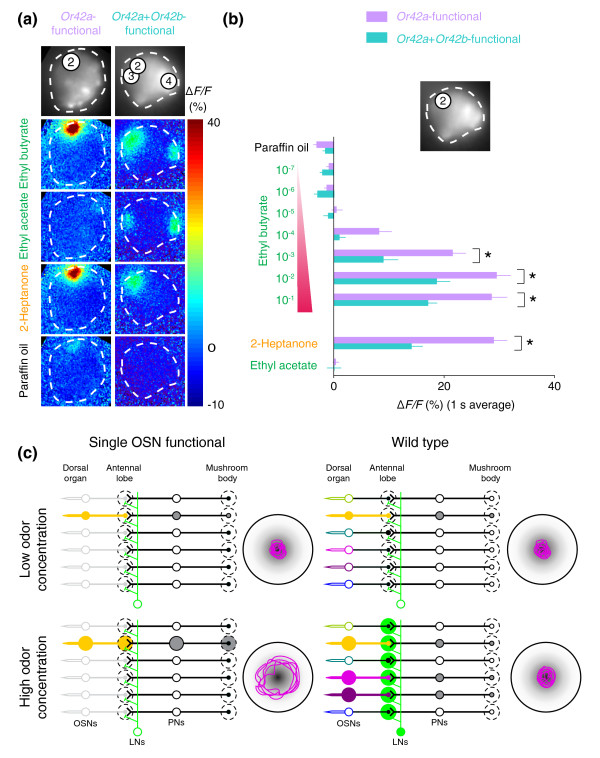
Modulation of odor-evoked signals in the mushroom body by addition of a second functional OSN. (a) Representative G-CaMP activity in PN terminals in mushroom body elicited by three odorants (10-2 dilution except ethyl acetate, 10-4 dilution) and paraffin oil (solvent) in Or42a+Or42b-functional larvae compared to Or42a-functional larvae (all but the ethyl acetate image are reprinted from Figure 5c). Top image shows intrinsic mushroom body G-CaMP fluorescence with overlaid numbers indicating the location of subdomains in Figure 5a. Bottom four images show false color-coded image of mushroom body taken 600 ms after stimulus onset, and represented as ΔF/F (%) (scale at the right). (b) Responses of subdomain 2 to high concentrations of ethyl butyrate are decreased in Or42a+Or42b-functional larvae compared to those in Or42a-functional larvae. Responses to a dilution series of ethyl butyrate, 2-Heptanone (10-2 odor dilution), ethyl acetate (10-4 dilution), and paraffin oil are calculated as the average ΔF/F over 1 s after odor stimulus onset (mean ± SEM). Purple: Or42a-functional larvae (n = 8). Light blue: responses from Or42a+Or42b-functional larvae, n = 5 except paraffin oil (n = 6), 10-4 and 10-2 dilutions of ethyl butyrate (n = 6), 10-2 dilution of 2-Heptanone (n = 6), and 10-4 dilution of ethyl acetate (n = 6). Responses that differ significantly between the two genotypes are indicated with an asterisk (*p < 0.01, Student's t-test). (c) Schematic model of gain control in the larval olfactory system. In single-OSN-functional animals (left), low concentrations of odor cause moderate activation of the single OSN and its PN, leading to attraction to the odor source (magenta trajectory to the right). High concentrations of odor fail to activate the LNs (green) and cause strong activation of the PN and corresponding behavioral avoidance of the odor. In wild-type animals, low odor concentrations activate a single OSN and its PN, leading to odor attraction. At high odor concentration, two additional OSNs are recruited and the LN network is activated, preventing PN activity from reaching saturation and maintaining stable attraction to the odor.